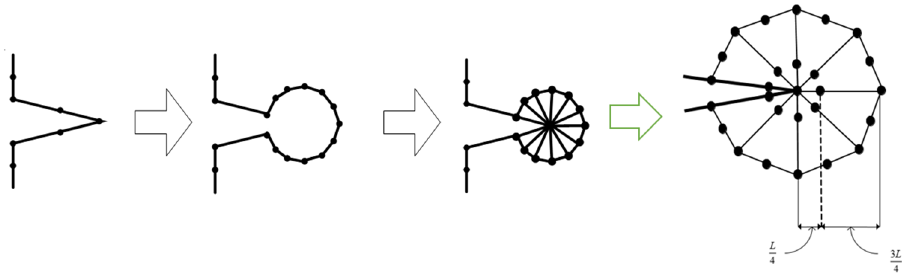
Figure 3. Special quarter-point finite elements at a crack front.